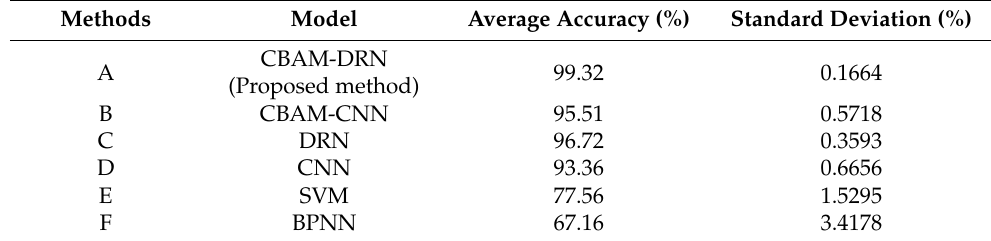
Figure 11. Diagnosis results of ten experiments with various fault diagnosis methods .. Table 6. Diagnosis results of different